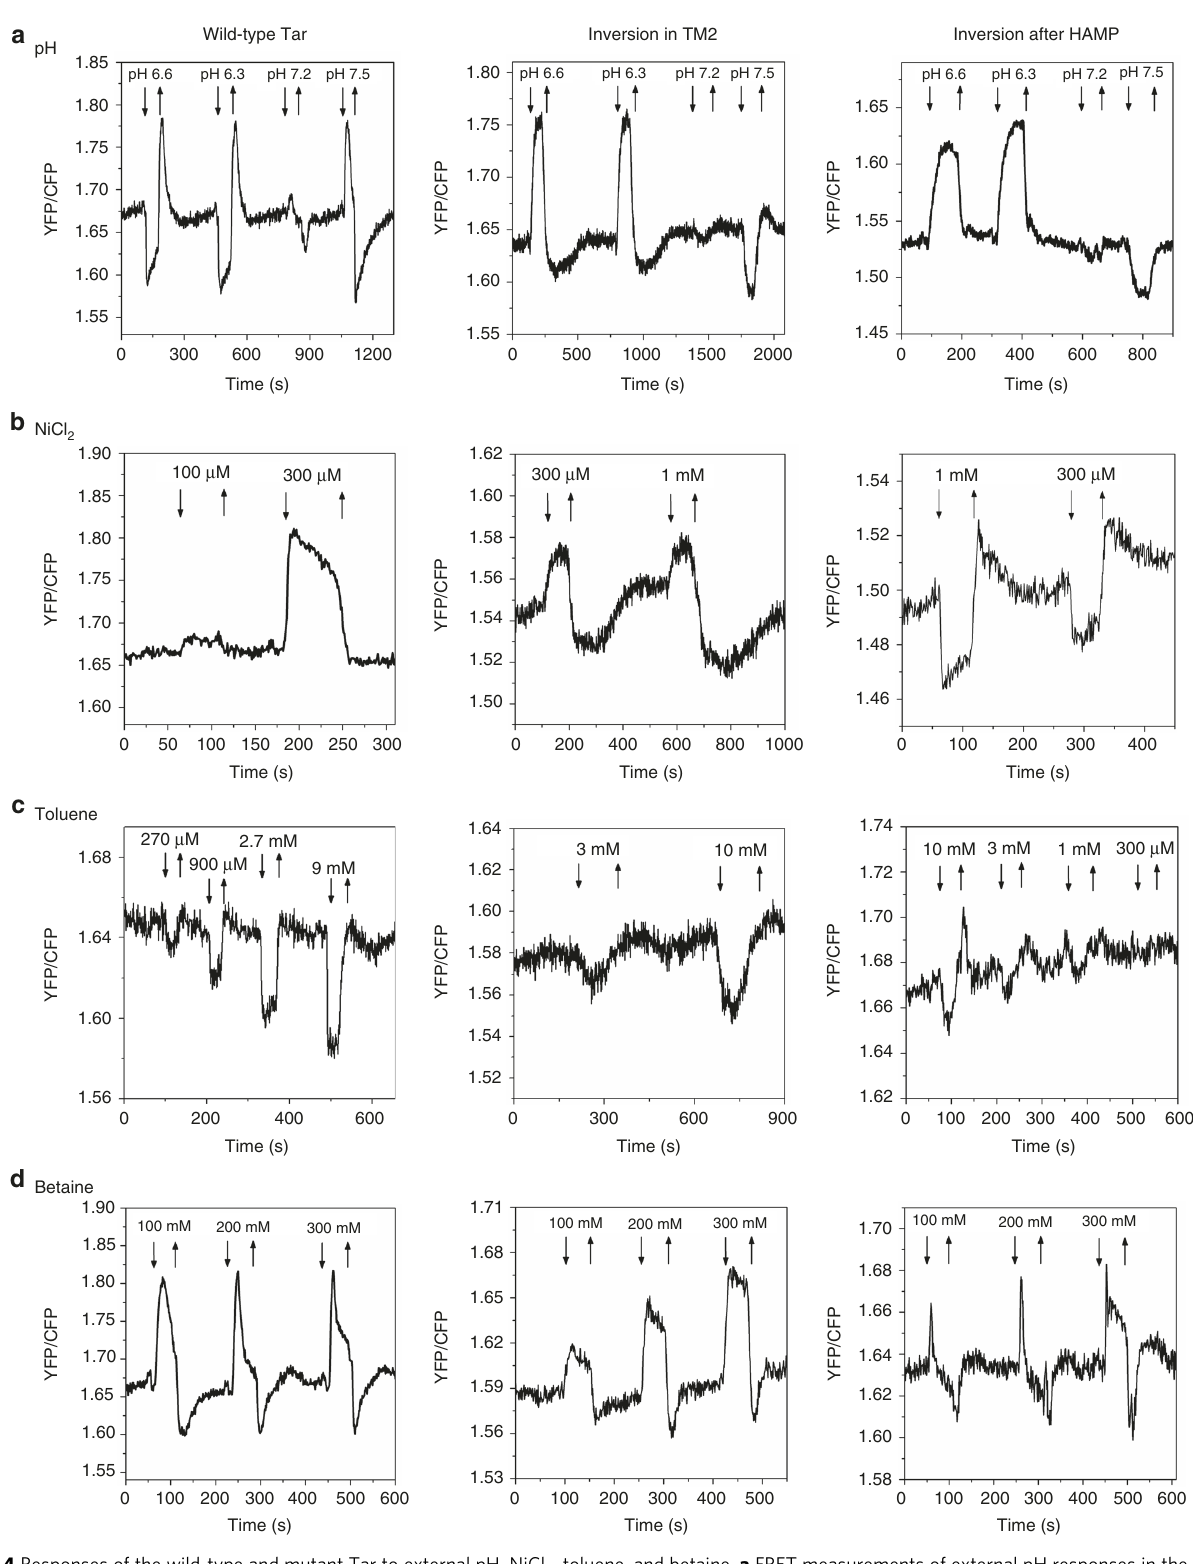
Fig. 4 Responses of the wild-type and mutant Tar to external pH, NiCl 2 , toluene, and betaine. a FRET measurements of external pH responses in the CheR + CheB + E. coli strain VS181 that expresses only the wild-type Tar, Tar TM2 + 2I (inversion in TM2), or Tar HAMP_GVPQM (inversion after HAMP). Cells were pre-adapted in the buffer at neutral pH (7.0) prior to stimulation with decrease or increase in pH. b – d FRET responses to a stepwise addition (down arrow) and subsequent removal (up arrow) of the indicated concentrations of NiCl 2 ( b ), toluene ( c ), or betaine ( d